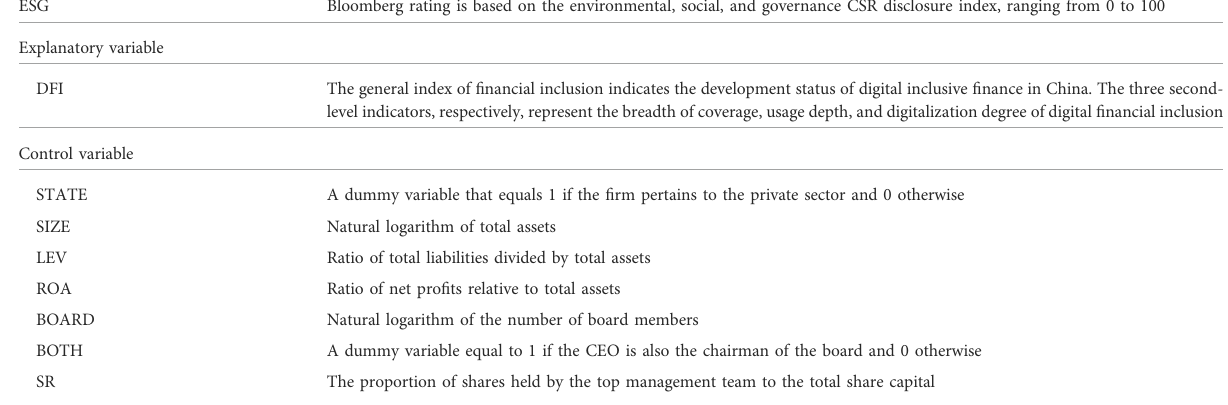
TABLE 1 Variable de fi